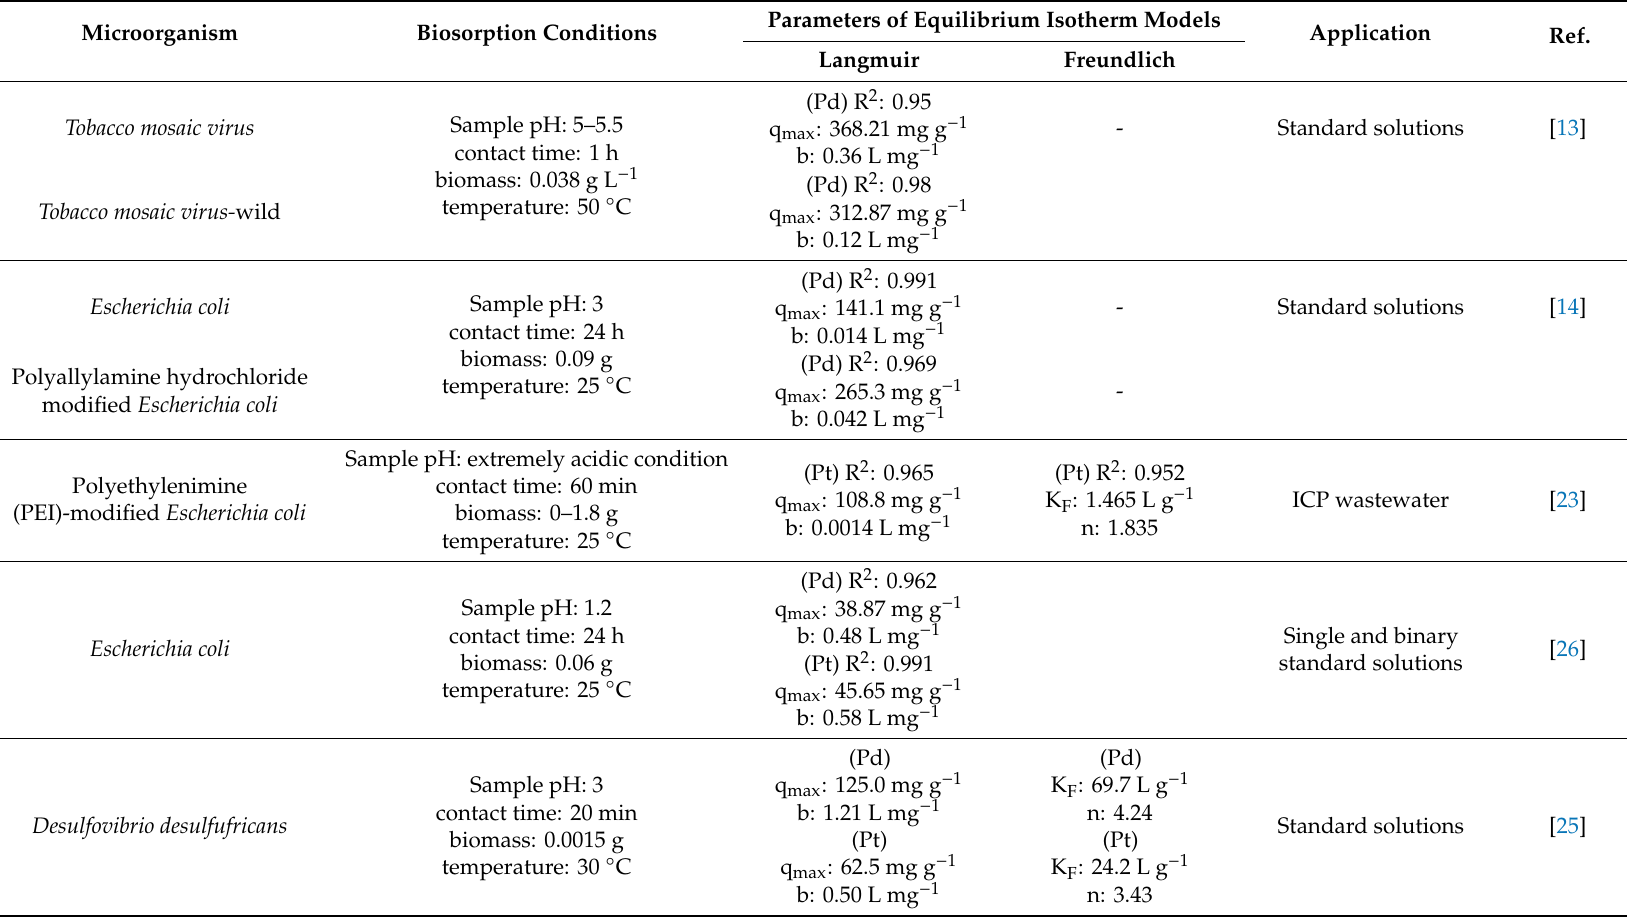
Table 1. Biosorption conditions and parameters of isotherm adsorption models of Pd(II) and Pt(IV) on various microorganisms.